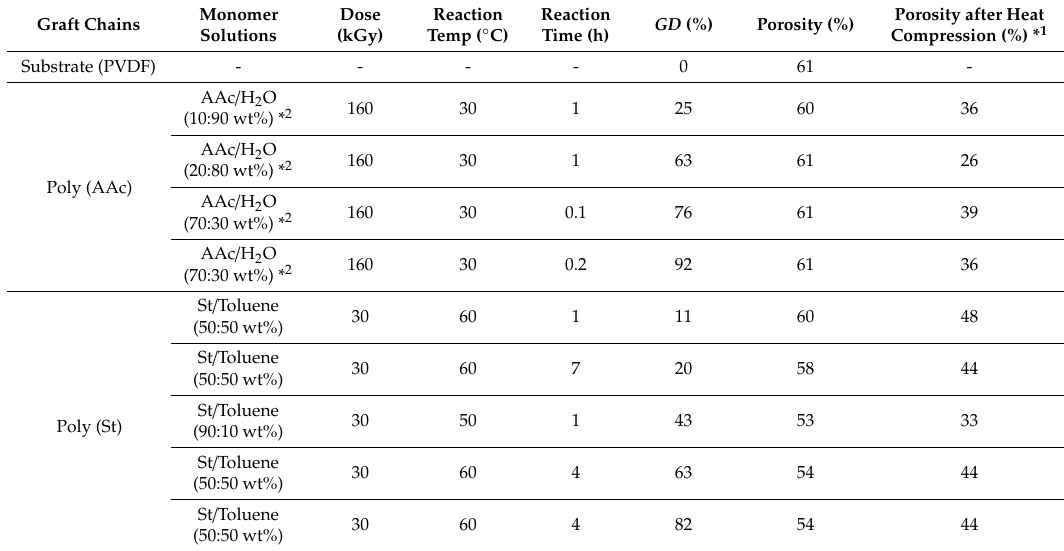
Porosity after Heat Compression (%) *